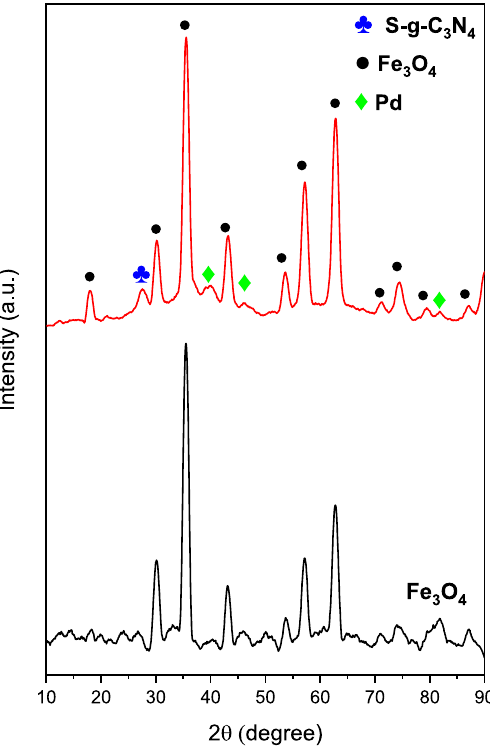
Figure 2. XRD pattern of SGCN/Fe 3 O 4 /PVIs/Pd nanocomposite.